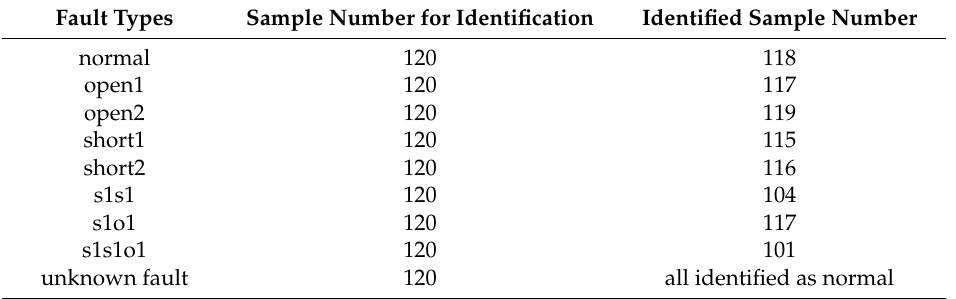
Table 10. Eight faults and the unknown fault identification accuracy in testing phase of the field experiment.